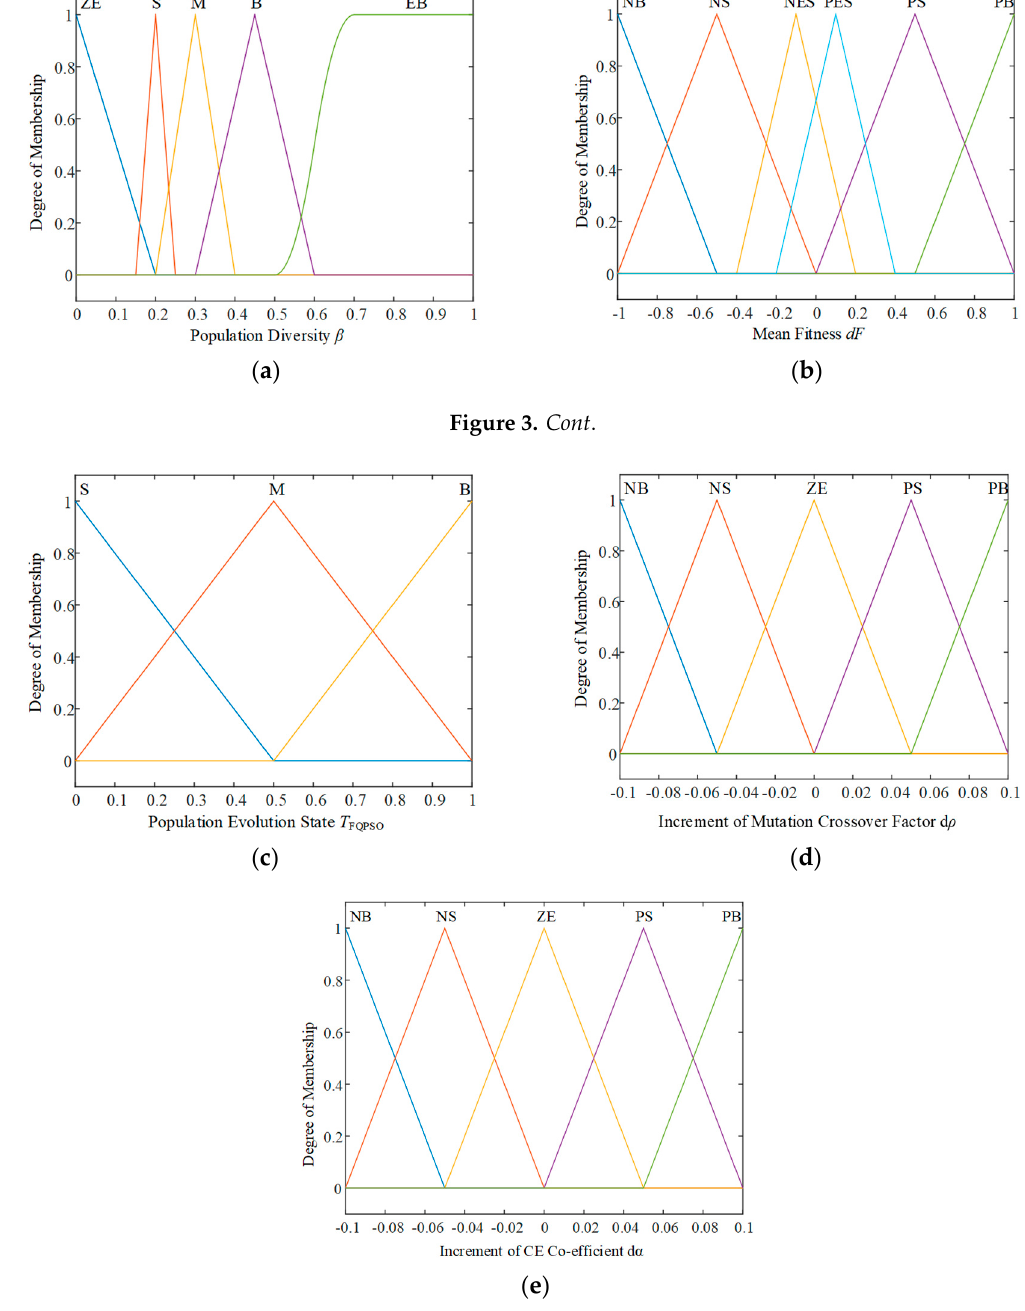
Figure 3. The membership function for the ( a ) population diversity, ( b ) mean fitness, ( c ) population evolution state, ( d ) increment of mutation crossover factor, ( e ) increment of CE co-efficient.